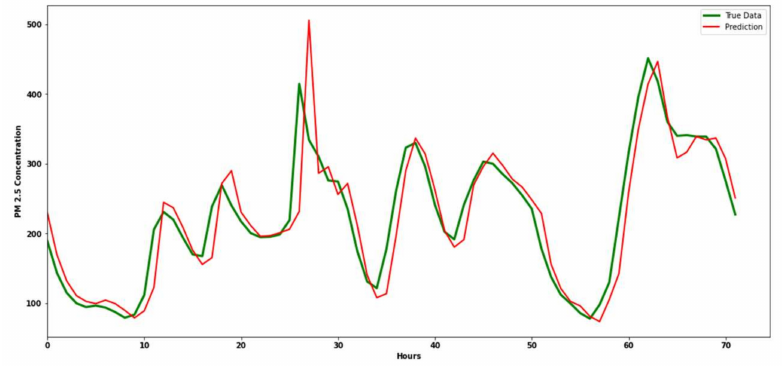
Figure 13. Forecasting for the next 72 h for Lahore using the LSTM encoder–decoder model.